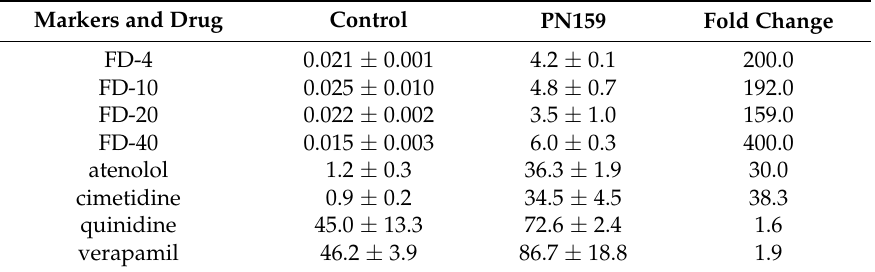
Table 2. Apparent permeability coefficients of dextran marker molecules and drugs in the apical-basal direction (P app A-B, 10 − 6 cm/s) in control and PN159 treated cultures. The differences between control and treated groups were expressed in fold changes. FD, fluorescein isothiocyanate-labeled dextran. Markers and Drug